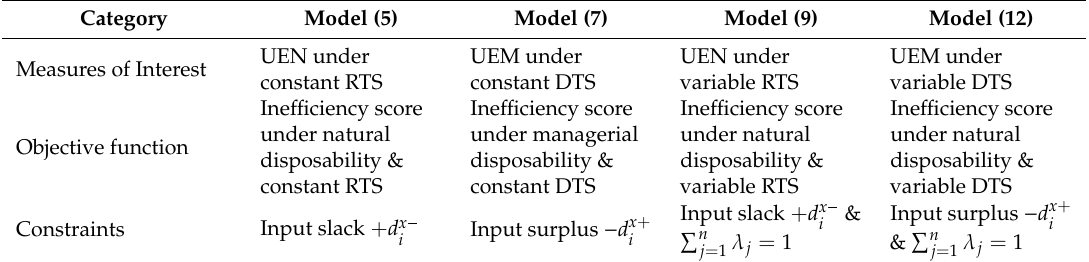
Table 3. Di ff erences among models for DEA environmental